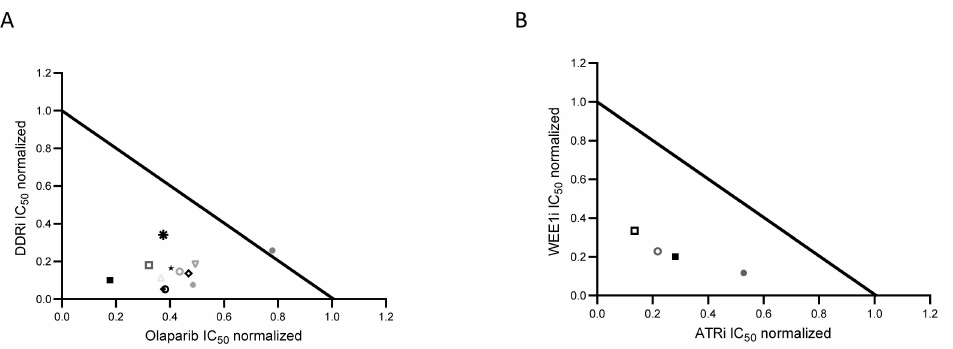
Figure 5. Synergistic combinations of DDR agents and olaparib. ( A ) Normalized IC 50 isobolograms showing the synergistic effects of the combination of olaparib with the inhibitors of ATR (F3 ; F3 OlaR ; Brca1-/- ; Brca1-/- OlaR ), Chk1 (F3 ; F3 OlaR ; Brca1-/- ; Brca1-/- OlaR ) and Wee1 (F3 ; F3 OlaR ; Brca1-/- ; Brca1-/- OlaR ). ( B ) Normalized IC 50 isobolograms showing the synergistic effects of the combination of ATRi AZD6738 and the WEE1i AZD1775 in F3 (●), F3 OlaR ( ), Brca1-/- ( ) and Brca1-/- OlaR ( ). Data are the mean ± SD of three independent experiments.